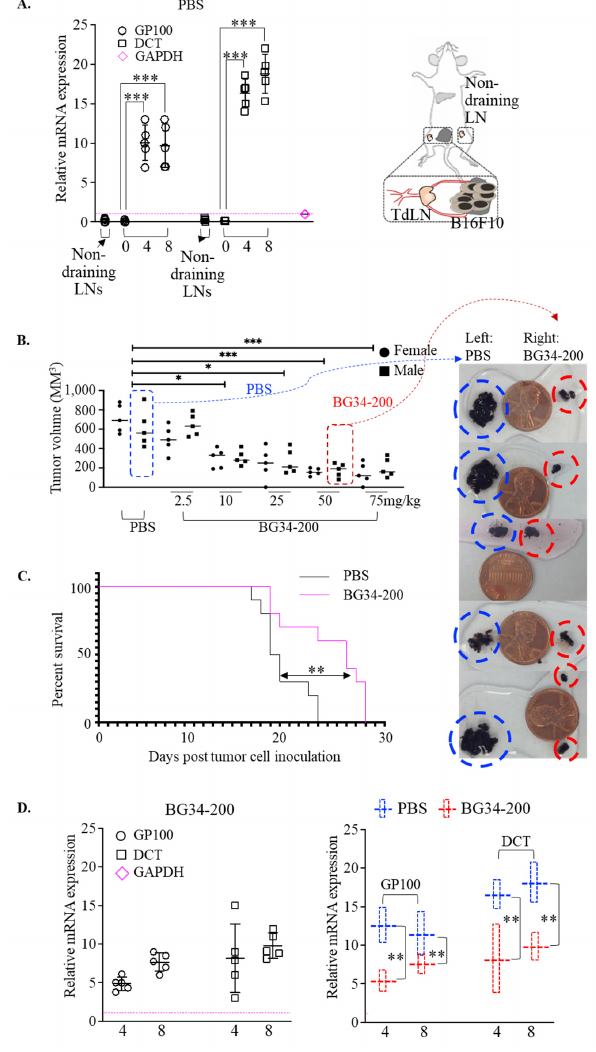
Figure 1. BG34-200 IV administration induces antitumor effect in B16F10 model of advanced mela- noma. ( A ). Relative mRNA expression of GP100 and DCT in lymph nodes (LNs) of control B16F10 mice (PBS-treated) as determined by RT-PCR. One and a half million B16F10 cells were inoculated into the left flank of C57BL/6J mice on day 0. Tumor-draining lymph nodes (TdLNs) were harvested on day 0, 4, and 8 to examine the mRNA expression. The non-draining LNs harvested on day 0 serve as control. The mRNA expression level was normalized to internal control GAPDH. ( B ). Tumor volumes in mice receiving IV administration of PBS or BG34-200 solution. PBS or BG34-200 of 5 different doses was IV-administrated on days 4 and 10 after tumor cell inoculation. Mice were eu- thanized on day 18 to measure the tumor volume. n = 10/group. Equal number of female and male